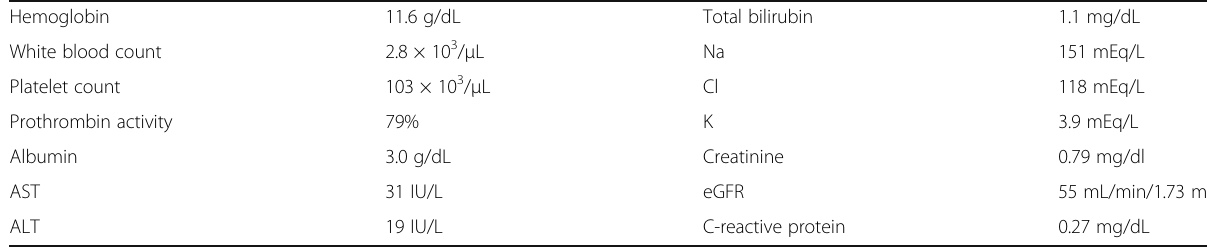
Table 1 Preoperative laboratory findings Hemoglobin